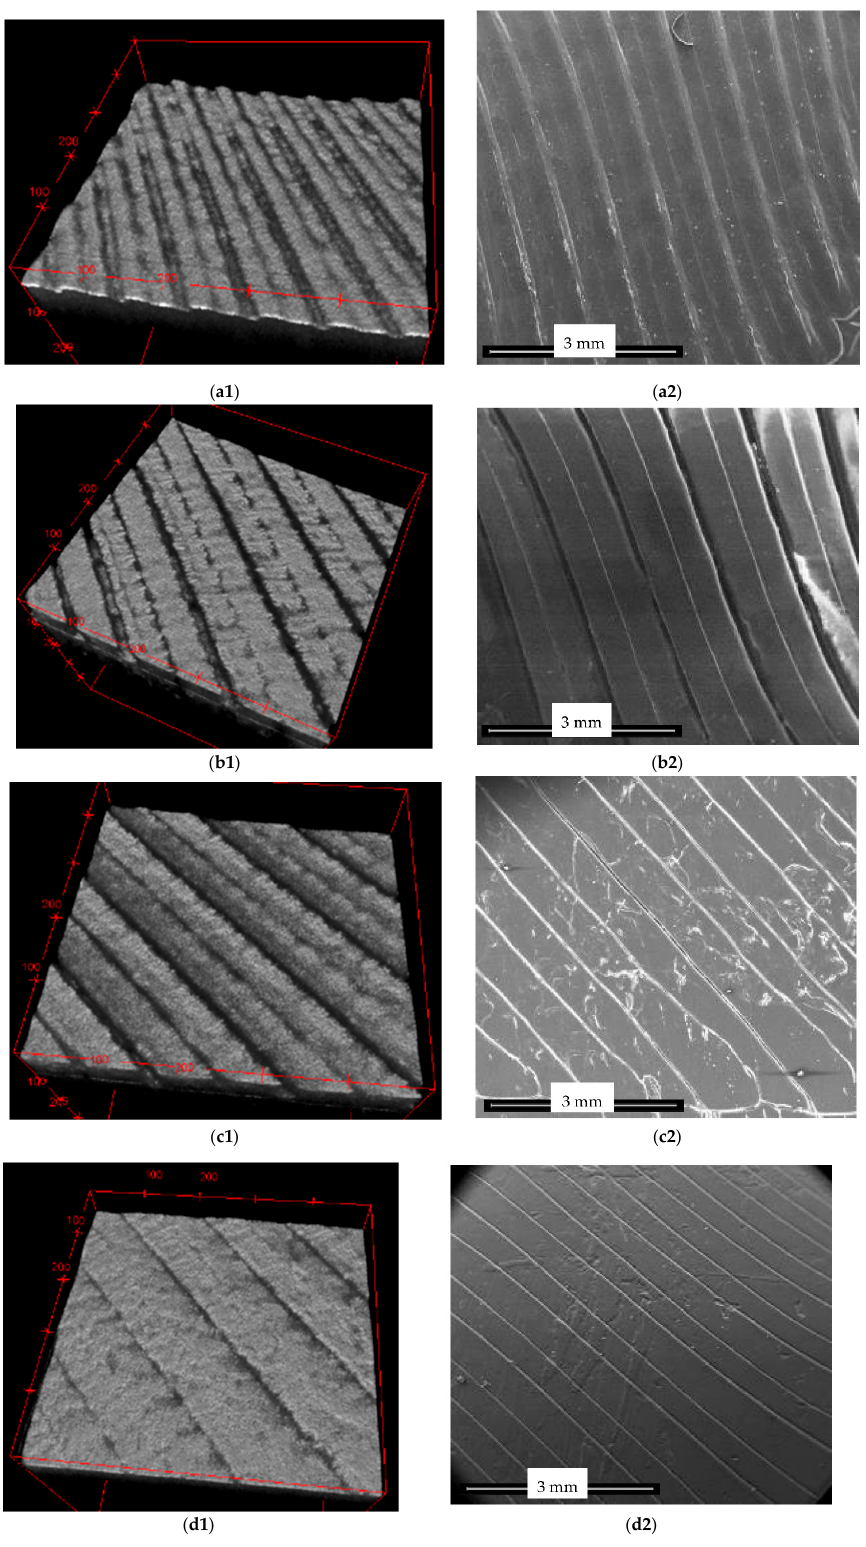
Figure 4. Imaging of the sample plates at different levels in the biogas reactor: ( a1,a2 ) control plate; ( b1,b2 ) top plate (situated in the upper part of the bioreactor); ( c1,c2 ) middle plate (situated in the central part of the bioreactor); ( d1,d2 ) bottom plate (situated in the densest part of the substrate in the bioreactor). Images in the column ( a1–d1 ) on left represent 3D OCT reconstructions with a surface area of 3.5 × 3.5 mm 2 , while column ( a2–d2 ) on right represent SEM images of the corresponding plate on left (gold-coated). One can observe the progressive degradation of the surface of the plates that are situated lower inside the bioreactor (i.e., from top to bottom) in comparison to the control plate, which is shown in Figure 4(a1,a2). Thus, the specific topography of the plates created by 3D printing (as pointed out in the beginning of Section 2), presented in Figure 4(a1,a2), shows only slight flattening for plates placed in the upper part of the reactor (i.e., in contact with gas and vapors)—Figure 4(b1,b2). This surface topography suffers more flattening further on for plates in the mid-part of the reactor (Figure 4(c1,c2)), while plates at the bottom are almost completely flat. This phenomenon that can be observed qualitatively on 3D OCT reconstructions can be quantified using OCT B-scans, as carried on in the following. Another aspect that can be concluded from Figure 4, this time by comparing the left and the right columns, is the good validation obtained for OCT volumetric reconstructions (left column) with higher-resolution SEM images (right column). Thus, one can conclude that OCT images (with 15 µm axial resolution, achievable by most OCT systems) can serve the scope of characterizing the impact of the reactor content on its walls. In this way, OCT may be considered for such evaluations instead of the more expensive and time- consuming SEM (even if its resolution is several orders of magnitude better, 4 nm). Details from the 3D OCT reconstructions are presented in Figure 5, on areas that are about 25 times smaller than the areas in the images in Figures 4 and 5(a1,a2). From the latter figure, the selected (0.7 × 0.7 mm 2 ) area for imaging a detail of the profile of a control plate is marked. The same observation as above can be made regarding the flattening of plate surfaces that are situated deeper inside the reactor—from the complexity of the 3D- printed profile in Figure 5(a1,a2) to the almost nonexistent topography in Figure 5d.